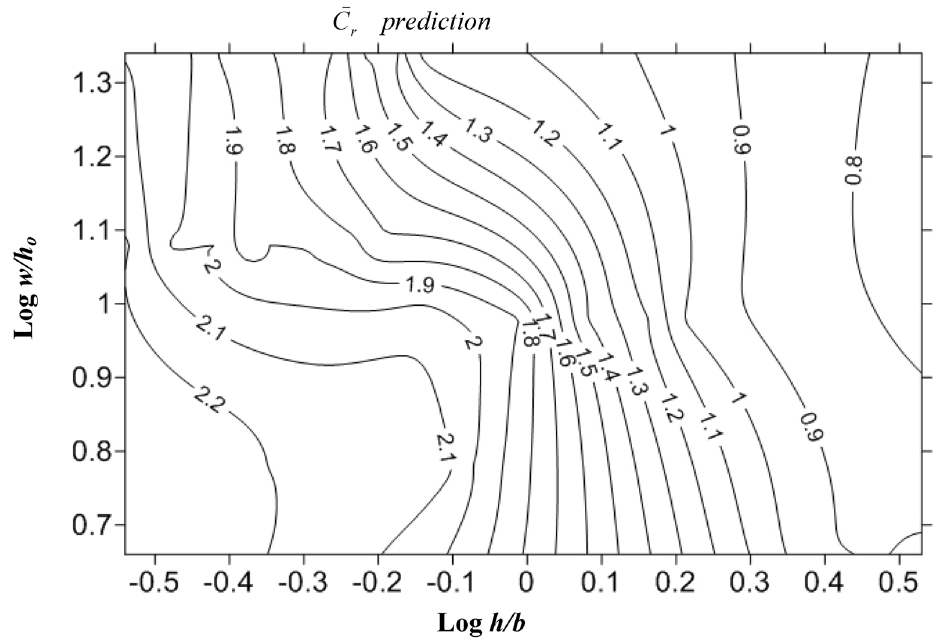
with h / b and proposed w / h (cid:3045)